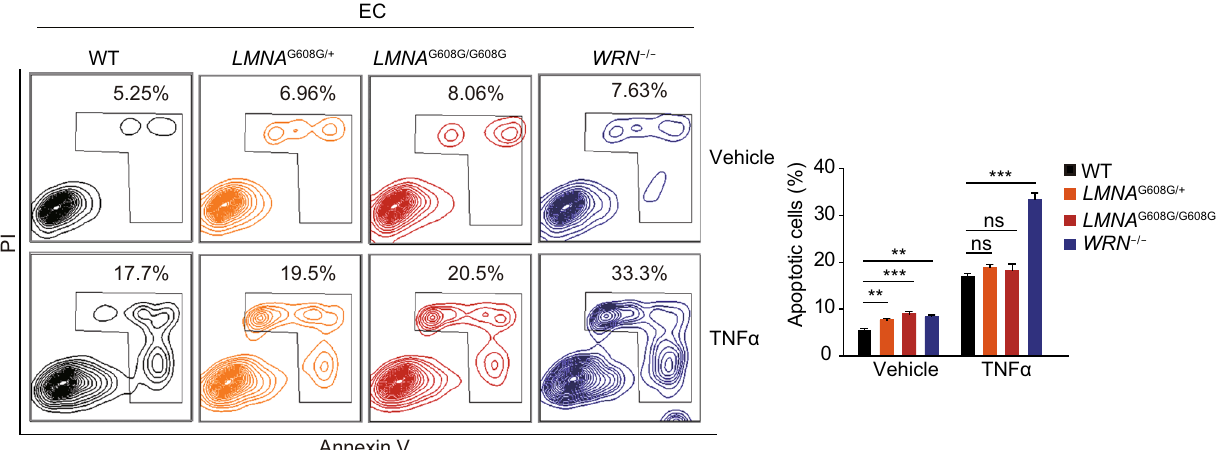
Figure 9. Cellular apoptosis analysis in HGPS-ECs and WS-ECs. Left: cellular apoptosis analysis by FACS after treatment with vehicle or TNF α in WT, heterozygous ( LMNA G608G/+ ), homozygous ( LMNA G608G/G608G ) and WRN − / − ECs. Right: percentages of apoptotic cells were presented as mean ± SEM, n = 3. *** P < 0.001; ** P < 0.01; ns, not signi fi